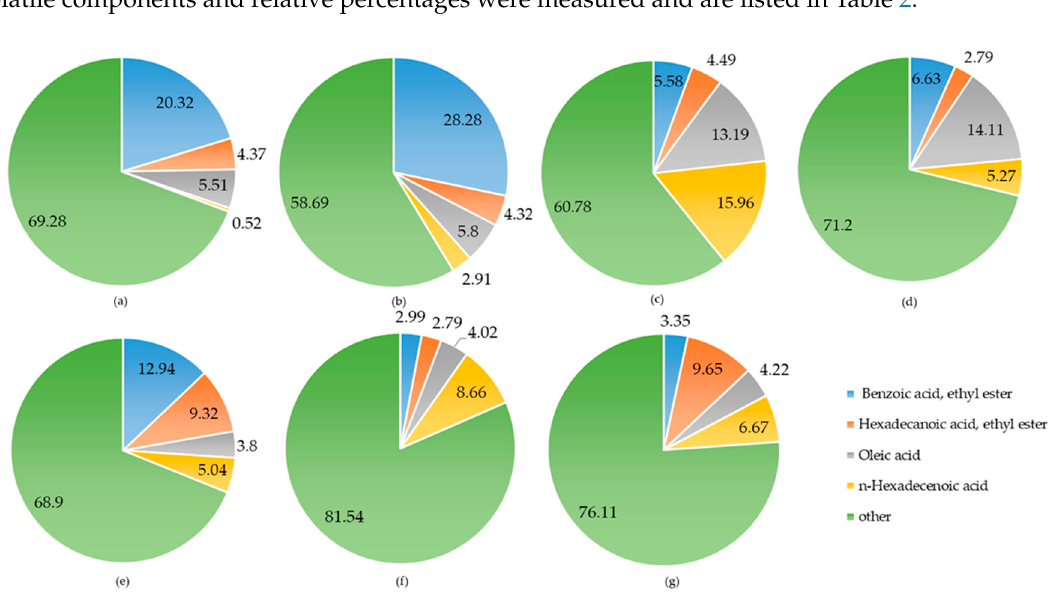
Figure 1. Chemical composition of alcohol extracts of different A. sinensis organs: ( a ) root; ( b ) peel; ( c ) blossom; ( d ) bark; ( e ) branch; ( f ) blade; and ( g ) seed.